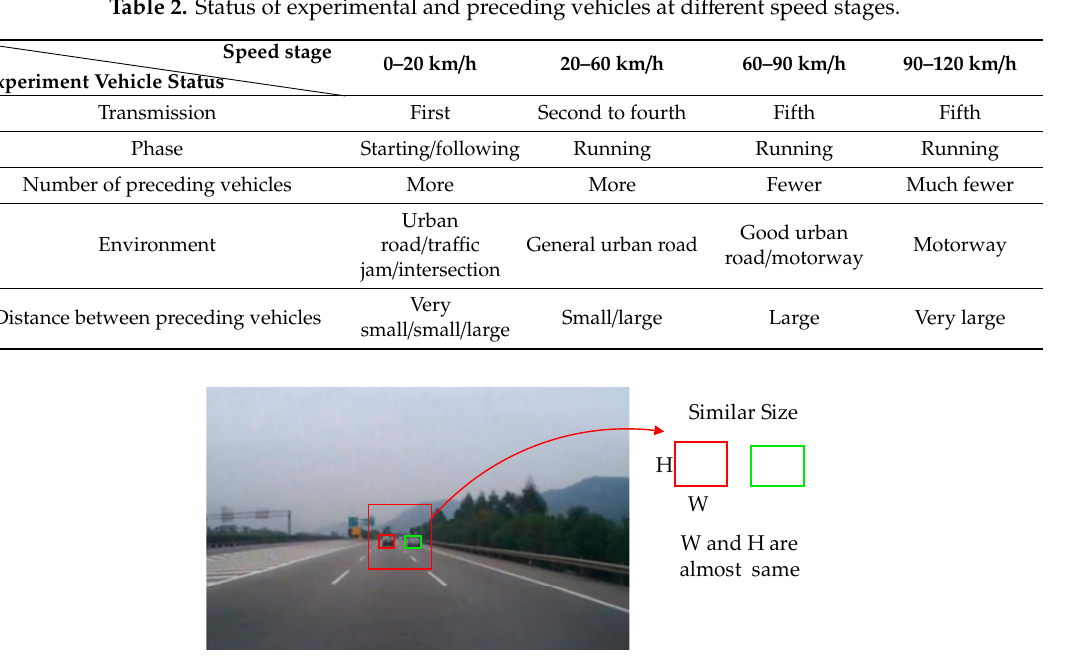
Table 2. Status of experimental and preceding vehicles at different speed stages.